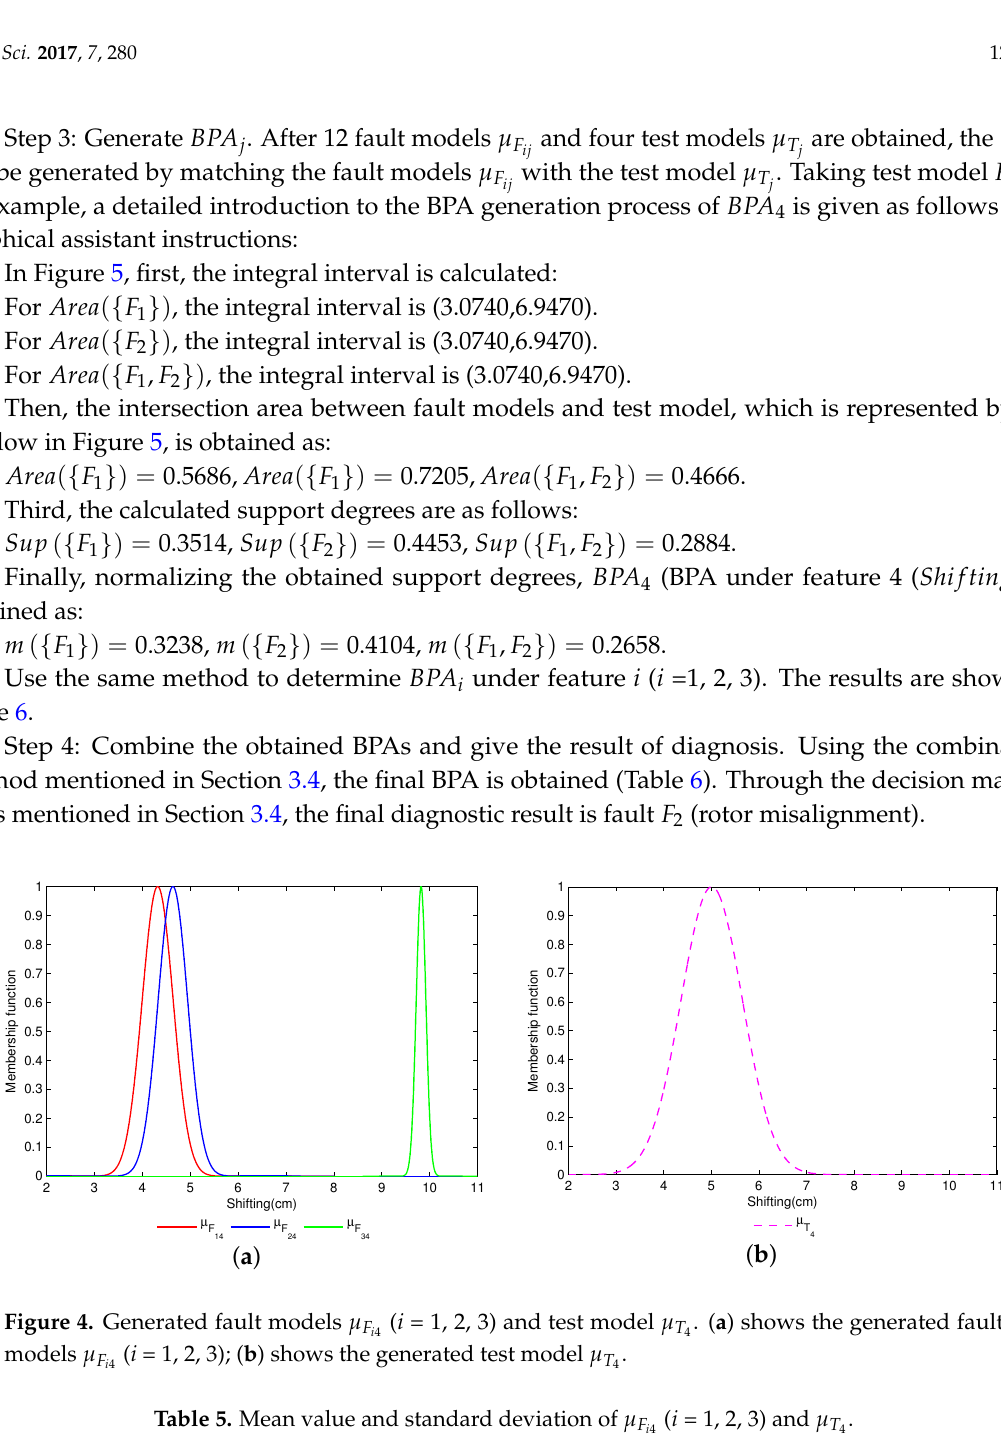
( i = 1, 2, 3) and test model µ T i 4